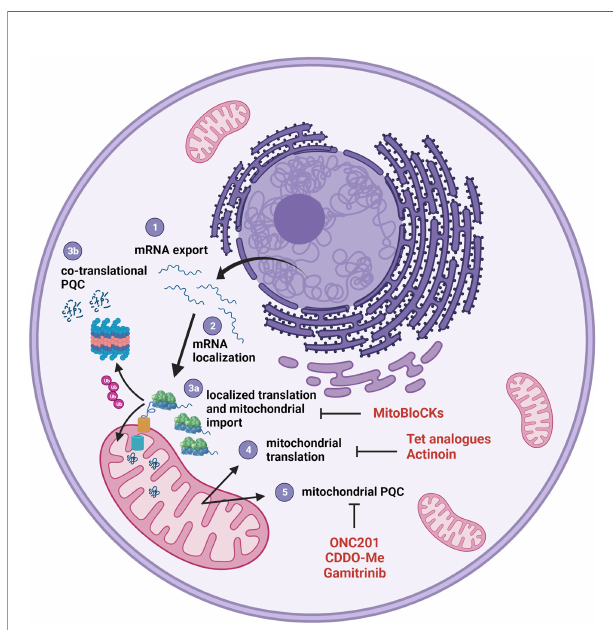
FIGURE 3 | The mitochondrial proteome is controlled at several levels. The vast majority of mitochondrial proteins is encoded by the nuclear genome; therefore, the transcribed mRNAs must be exported from the nucleus (1) to be translated into the cytosol. This translation process can be compartmentalized through a localization of transcript to the organelle (2) with the contribution of the protein synthesis machinery. Proteins synthesized on the surface of mitochondria can be imported via TOM/TIM (3a) or discarded and degraded if they don ’ t pass the PQC step (3b). mRNA translation (4) and associated PQC (5) also occur in the mitochondrial matrix. All these steps can be potentially targeted with compound listed in Table 1 and represented here in